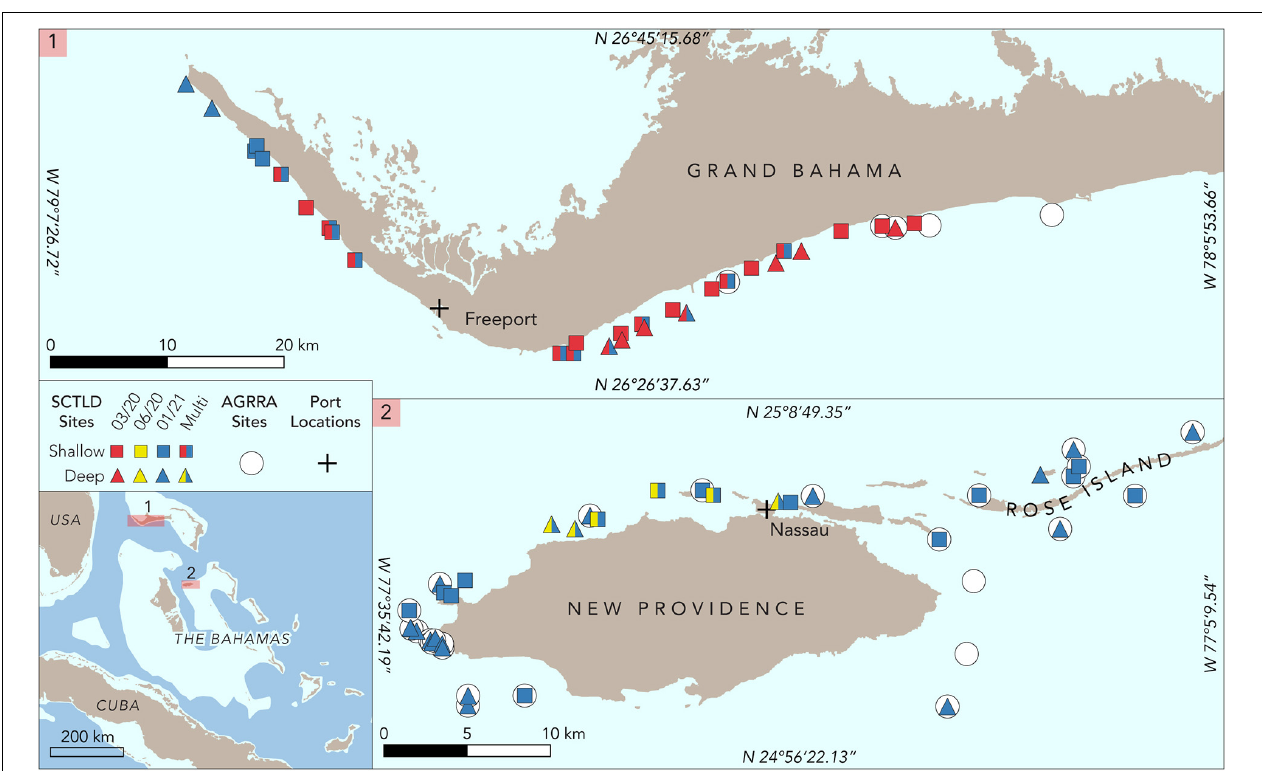
FIGURE 2 | Map of study sites for Grand Bahama and New Providence. Sites where Atlantic and Gulf Rapid Reef Assessment (AGRRA) surveys were conducted in 2019 are denoted by circles. Roving diver assessments on shallow sites are marked with squares and deep sites with triangles. Surveys conducted in March 2020 are shown in red, June 2020 in yellow, and January 2020 in blue. Sites with two colors are those that were assessed more than once. The location of commercial shipping ports for Grand Bahama and New Providence is marked with a